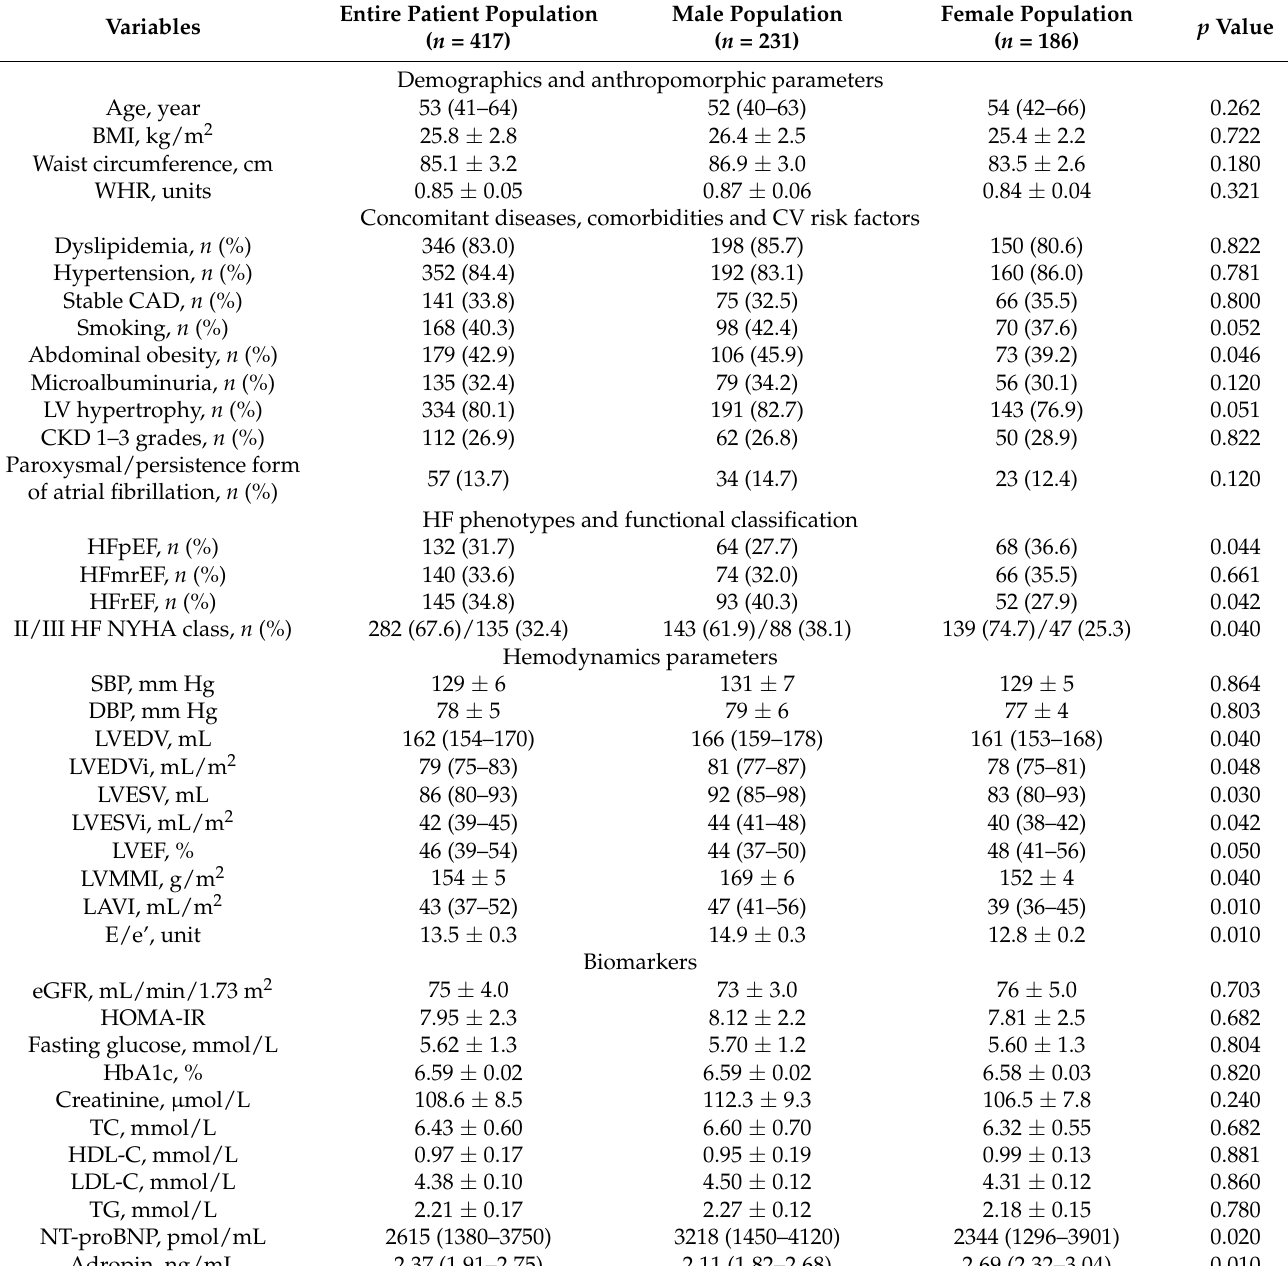
Table 1. Baseline general characteristics of eligible T2DM